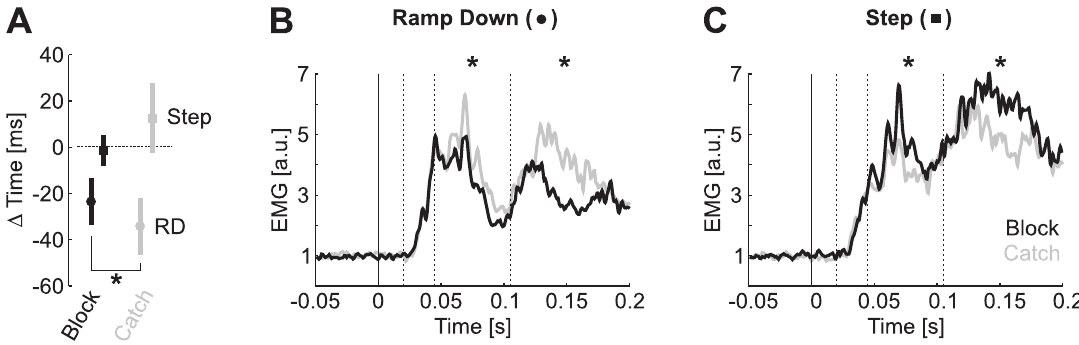
Figure 8. Effect of muscle pre-activation. A: Changes in reversal times relative to the average across all step responses from the block condition (similar as in Figure 4 C). Black and gray illustrate catch and block conditions while round and square items correspond to ramp-down and step responses, respectively. B: Response evoked by ramp-down perturbation when these profiles are expected (black) or presented as catch trials (gray). Data are from Brachioradialis and the trace is the average across subjects. Stars indicate that the response averaged in the corresponding time window differed significantly across catch and block conditions ( P , 0.05). C: Same as B for the responses following step perturbations (2 Nm).